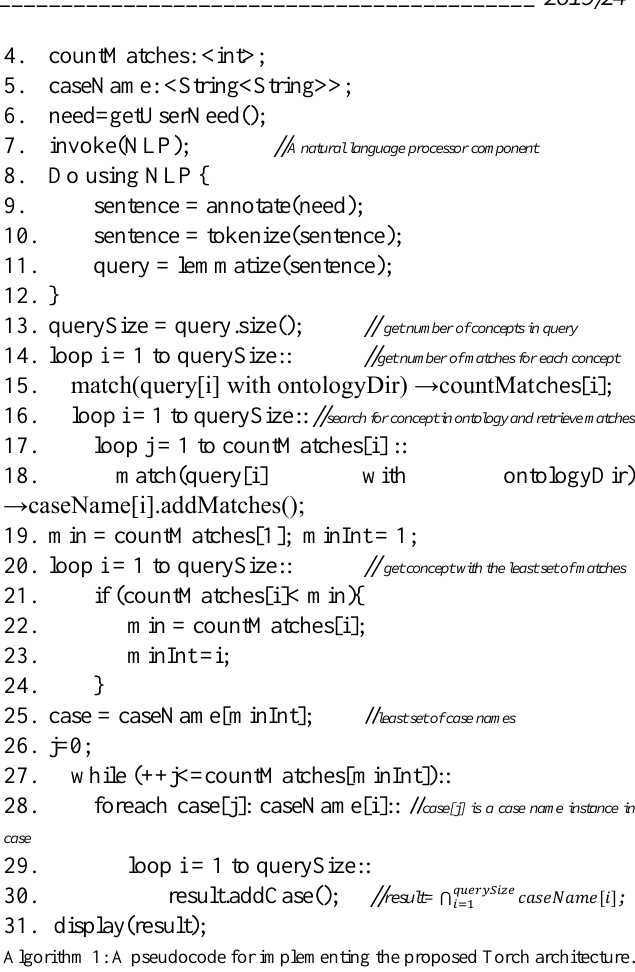
Algorithm 1: A pseudocode for implementing the proposed Torch